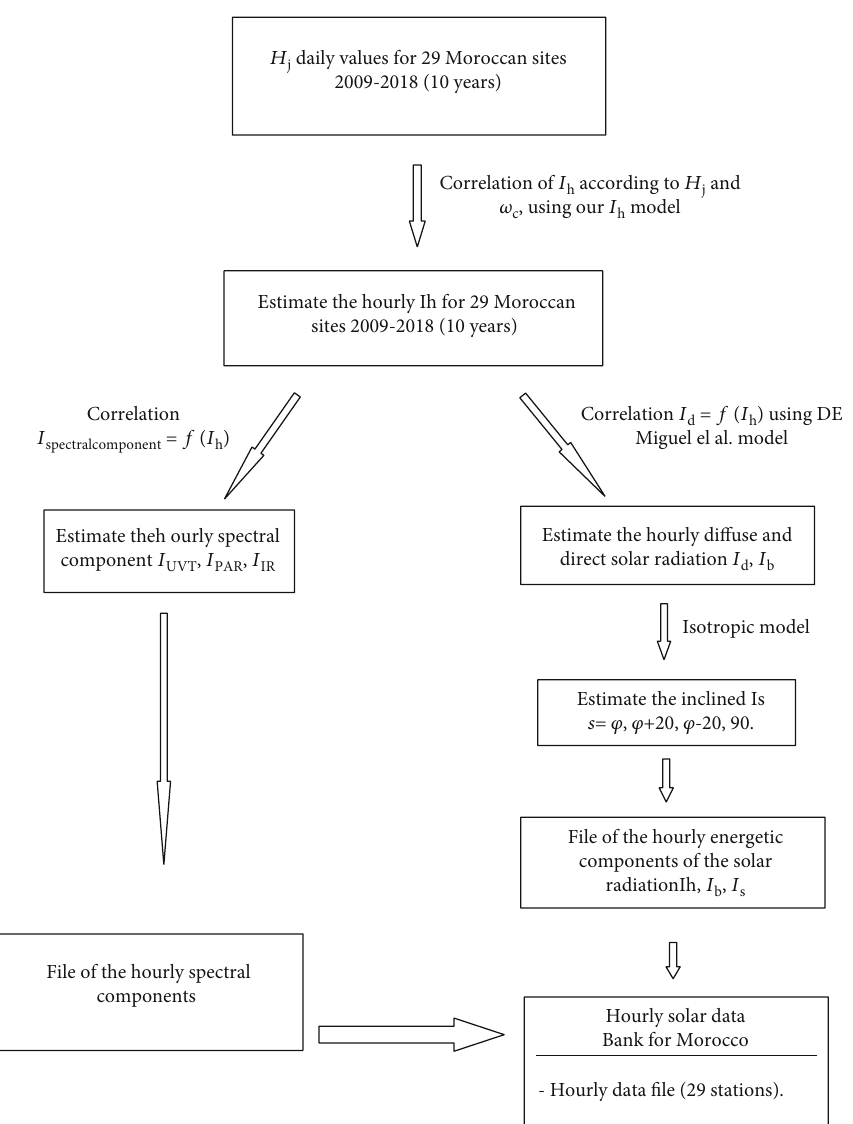
Figure 9: The main steps followed for creating the hourly solar database for